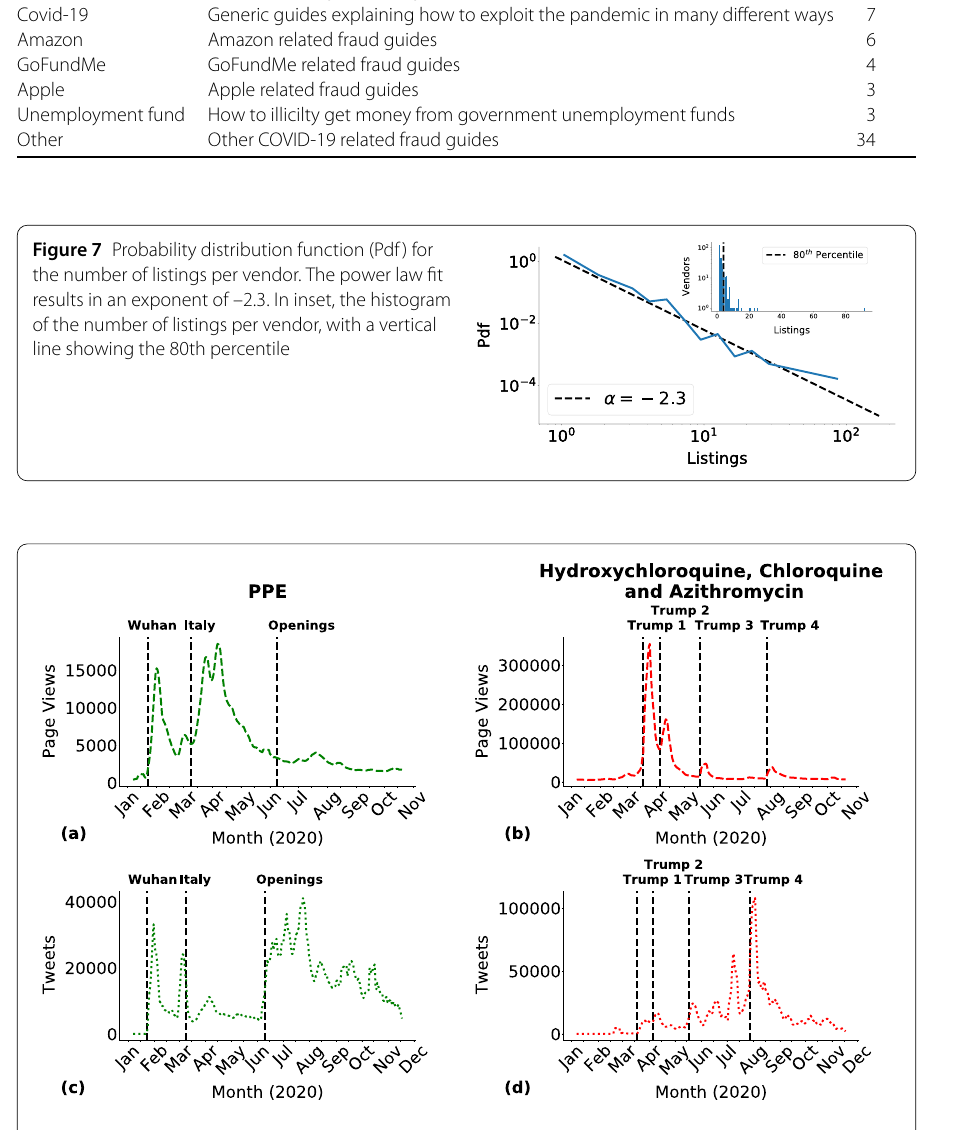
In order to complement Fig. 5(a) and (b) in the main text and properly show the peaks